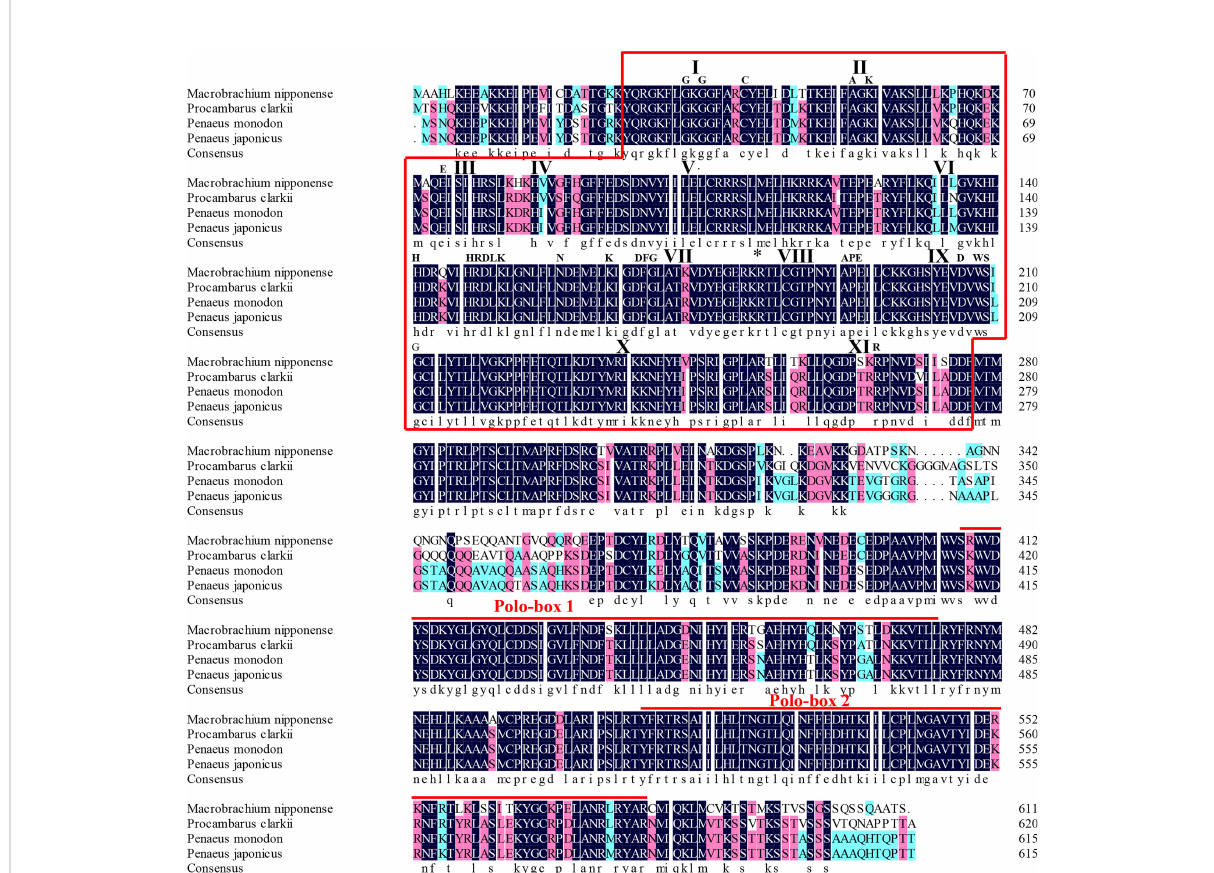
FIGURE 2 The similarity identity of amino acid sequences of Plk1 between different species. The Serine/Threonine (Ser/Thr) kinase domain composed of sub-domains I to XI is boxed. Important motifs and residues conserved in Ser/Thr kinases (HRDLKxN, KxxDFG, APE, DxWSxG and R) are indicated above the alignment. The asterisk indicates the position of the conserved T182 residue essential for kinase activation and the bullet point indicates the L104 residue involved in BI 2536 binding. The two Polo-box domains (PBD) are over-lined.